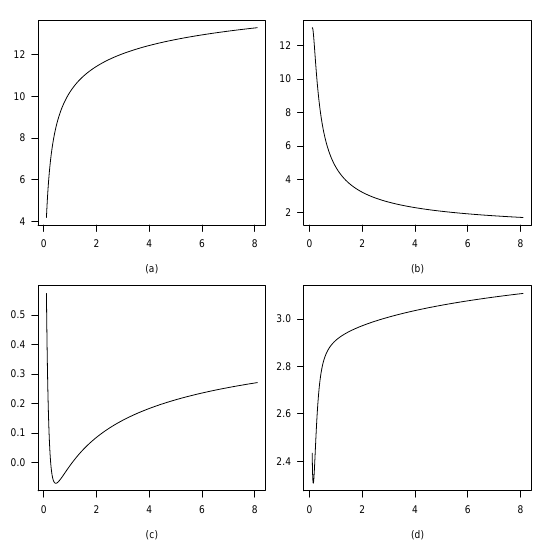
Figure 10 – Mean, in panel (a), variance, in panel (b), skewness, in panel (c), kurtosis, in panel (d), ( θ , α ) } , for M = 350, m = 20, θ = 0.51, and α > of the power hypergeometric distributions { r i